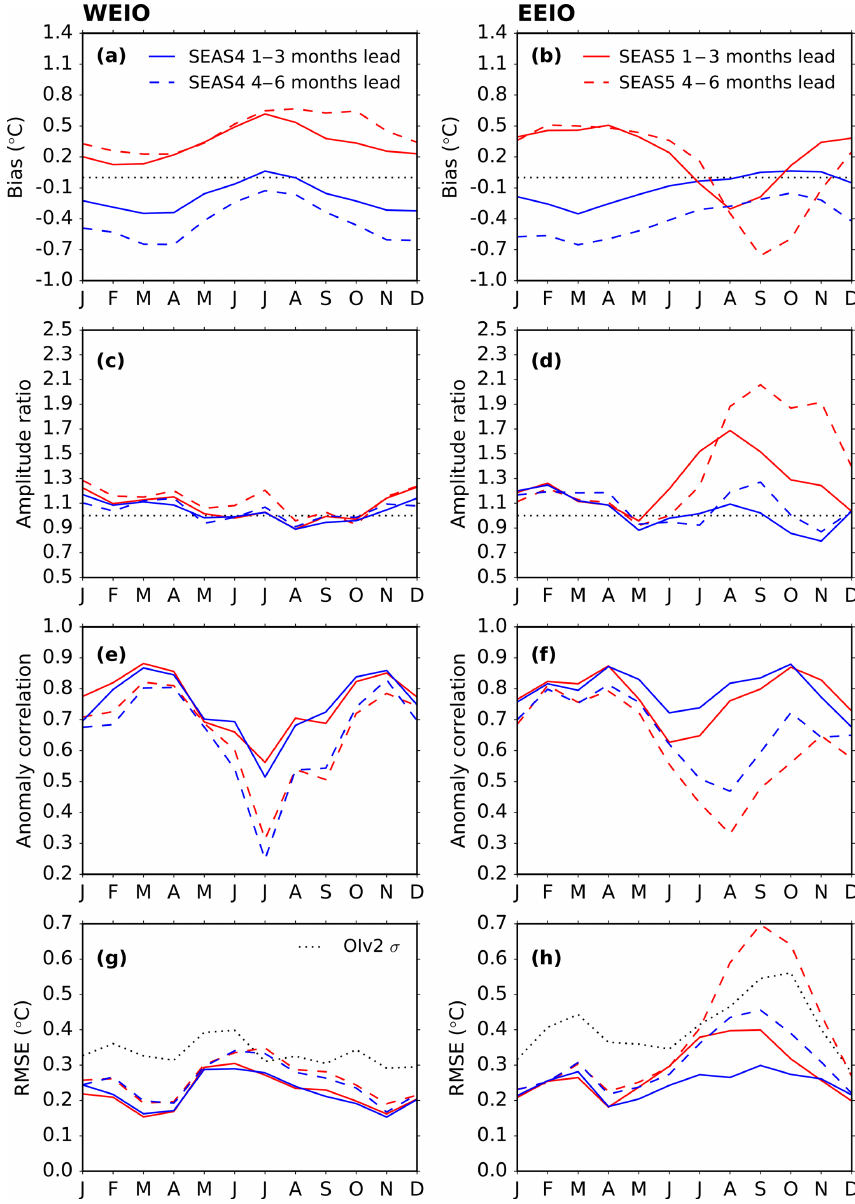
Figure 4. Forecast performance metrics of the regions that contribute to the Indian Ocean Dipole index (illustrated in Figure 1) as a function of verification month; (a, b) SST climatological bias; (c, d) Ratio of the standard deviation of forecast and OIv2 anomalies; (e, f) Anomaly correlation; (g, h) RMSE. SEAS4 is shown in blue and SEAS5 is shown in red. The solid lines are averaged over 1 to 3 months lead times, and the dashed lines are averaged over 4 to 6 months lead times. Each line uses 15 ensemble members. The standard deviation of the inter-annual variability in OIv2, indicating the annual cycle of the inter-annual variability, is plotted as the dotted line in panels (g) and (h)